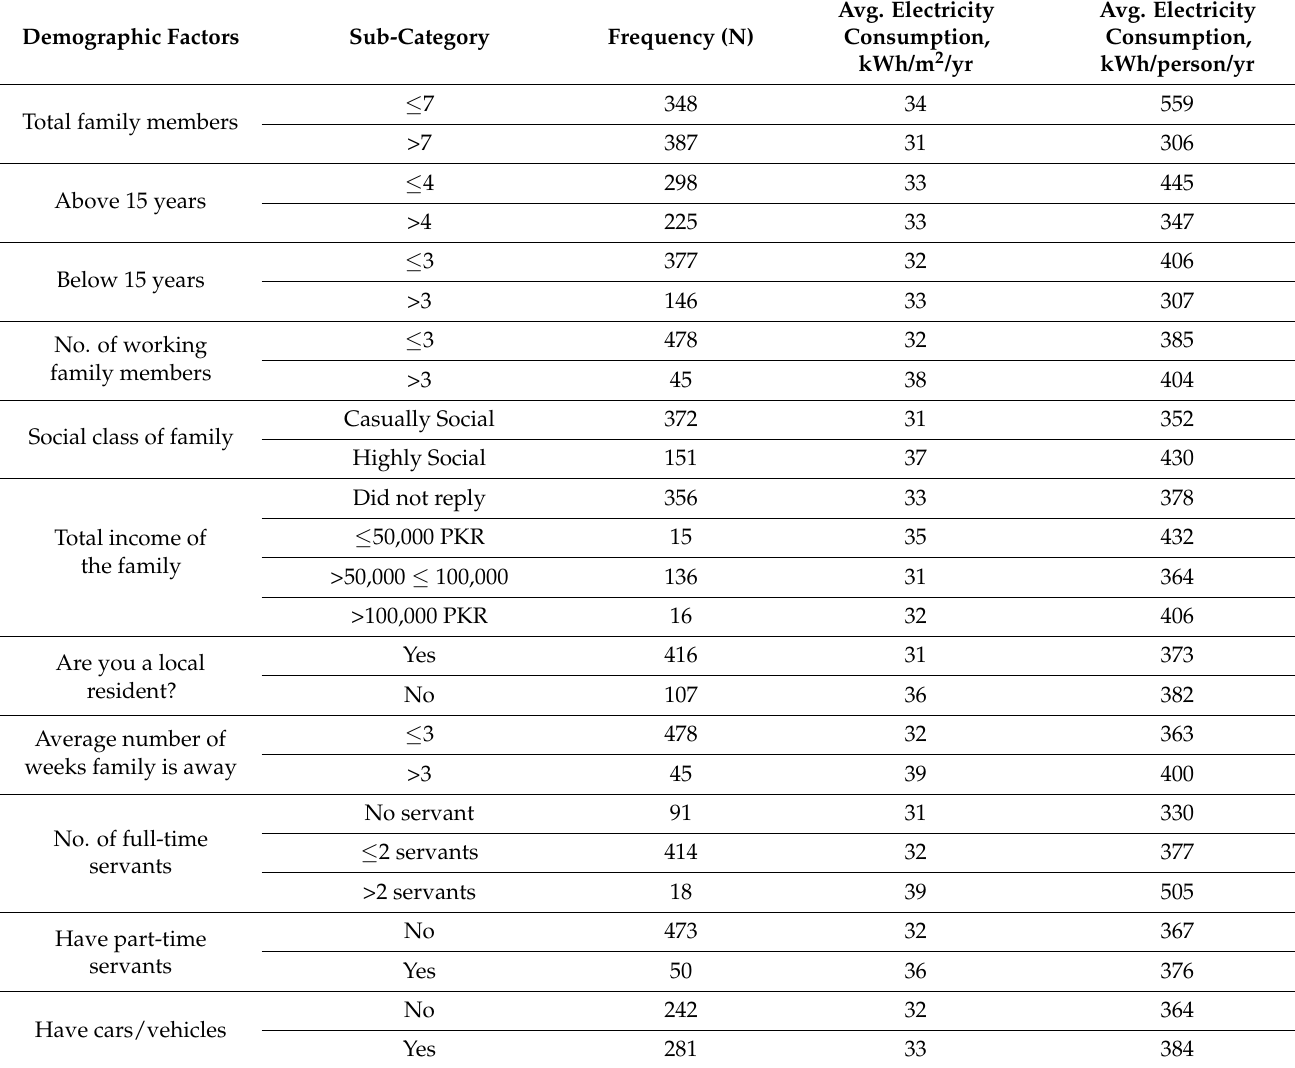
Table 3. Electricity consumption of demographic factors based on